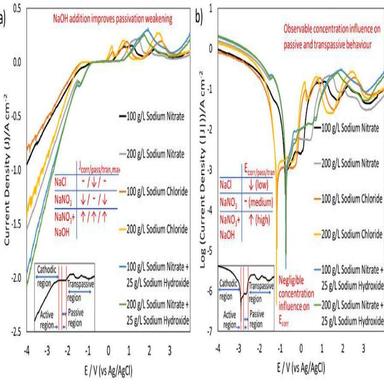
Linear sweep voltammograms of NbC–Ni in different electrolytes and concentration. a) Current density vs voltage sweep at 100 mV/s scan rate and its b) decadic logarithm.